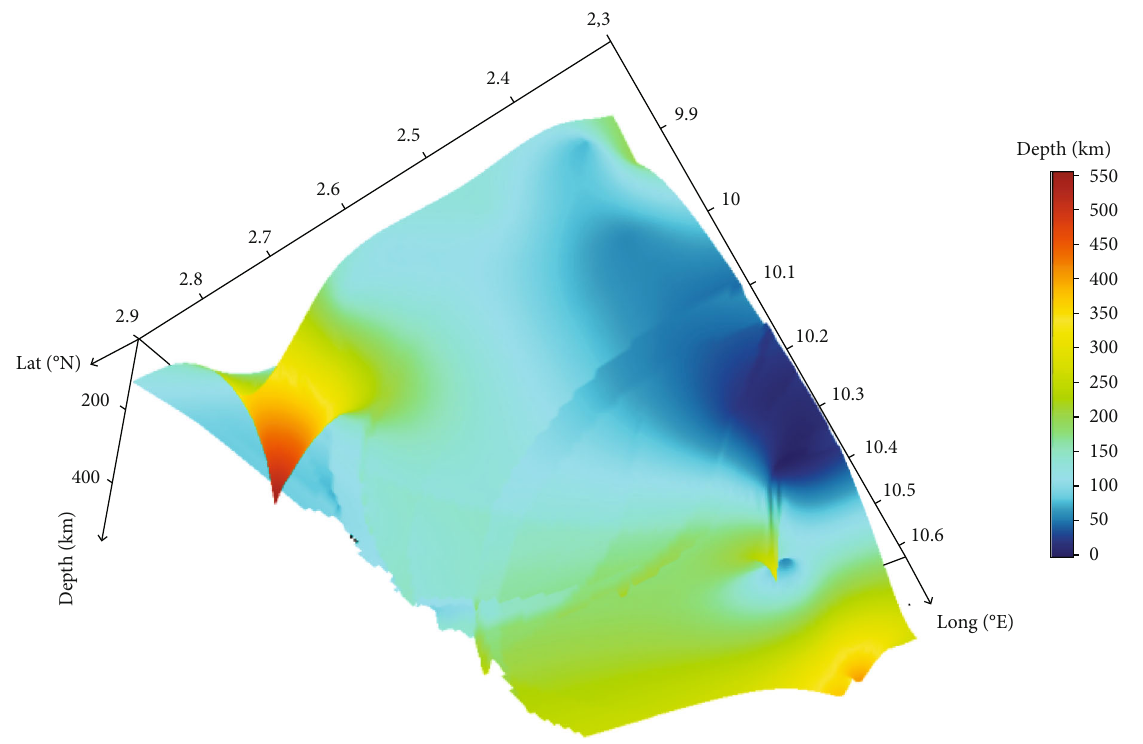
Figure 11: Depths of resistivity fi eld